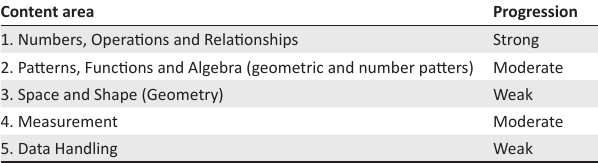
TABLE 7: Progression in the mathematics workbooks across content